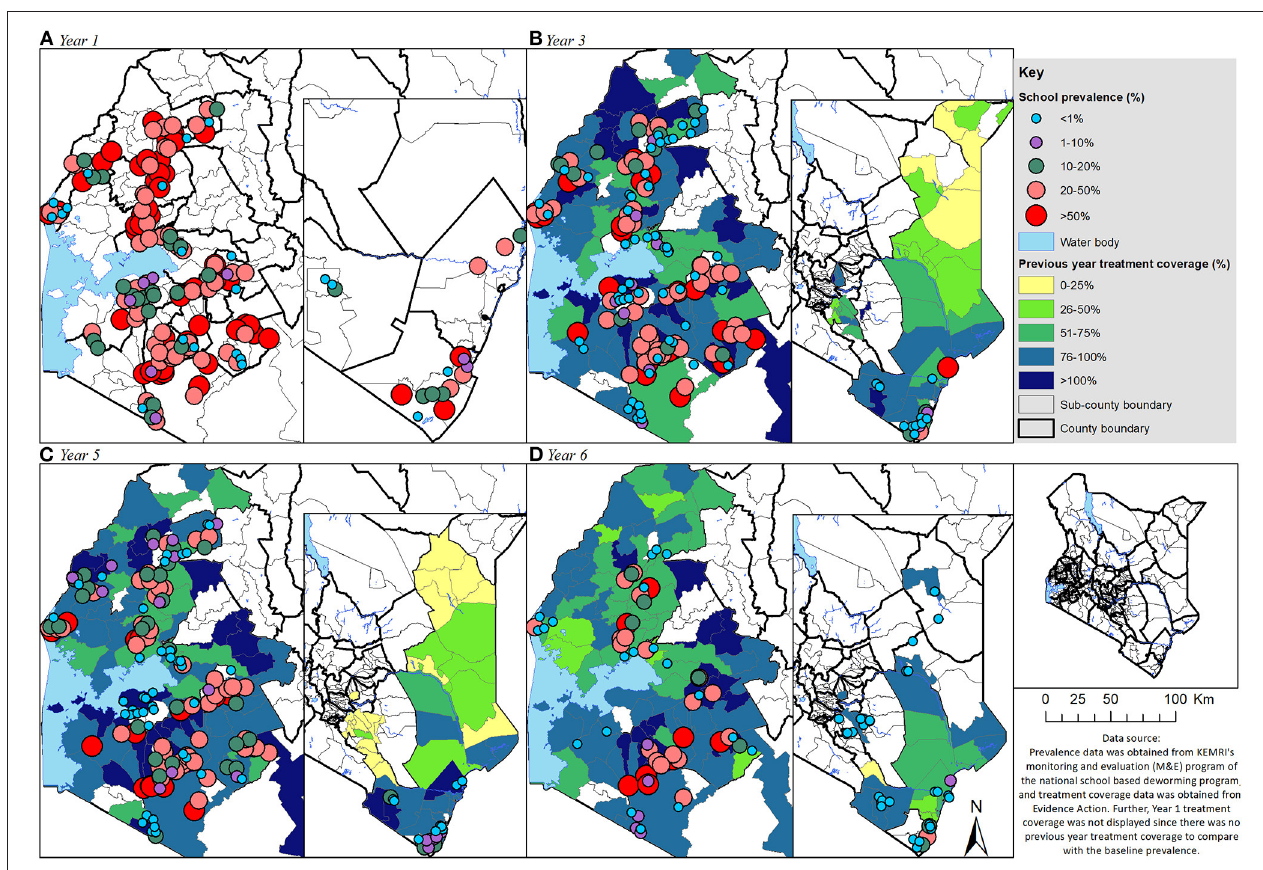
FIGURE 3 | Geographical distribution of the undifferentiated STH pre-treatment prevalence overlaid with the previous year treatment coverage ( A : Year 1, B : Year 3, C : Year 5, and D : Year 6) for the preschool aged (PSAC) group of children in Kenya.